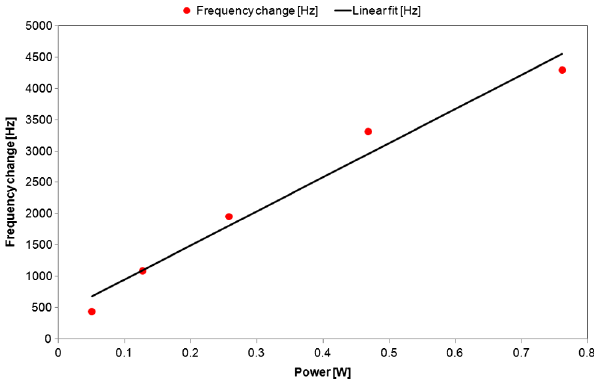
FIG. 9. LA-VWM frequency dependence on the power depo- sition in the target wire by a dc